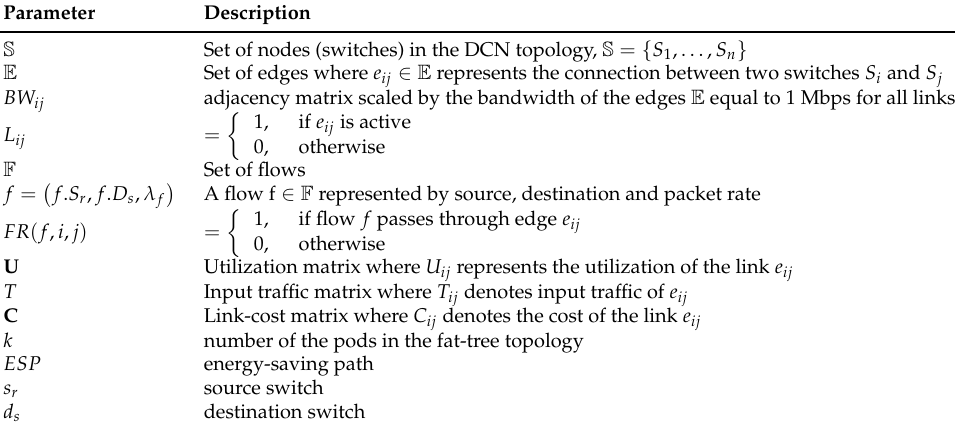
Table 2. List of